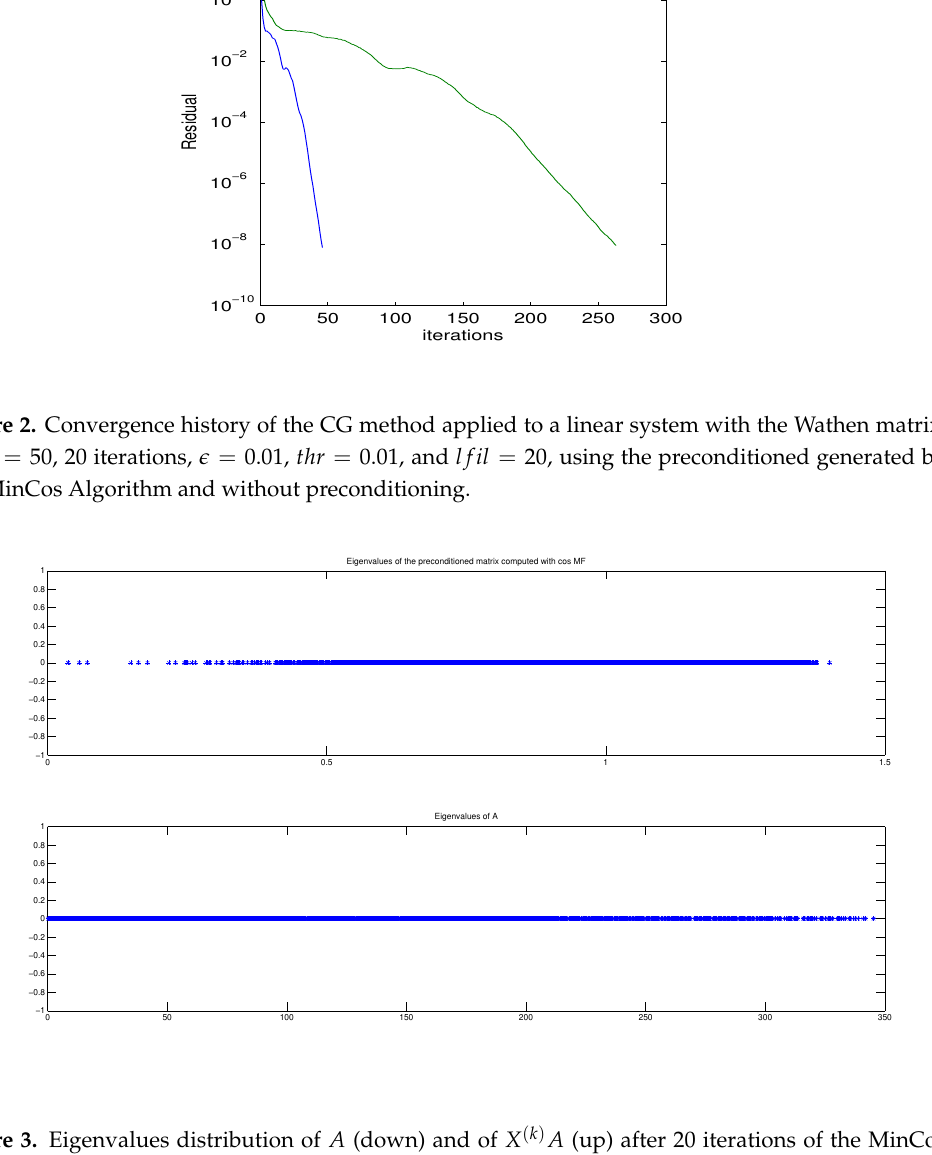
Figure 3. Eigenvalues distribution of A (down) and of X ( k ) A (up) after 20 iterations of the MinCos Algorithm when applied to the Wathen matrix for n = 50, (cid:101) = 0.01, thr = 0.01, and l fil =